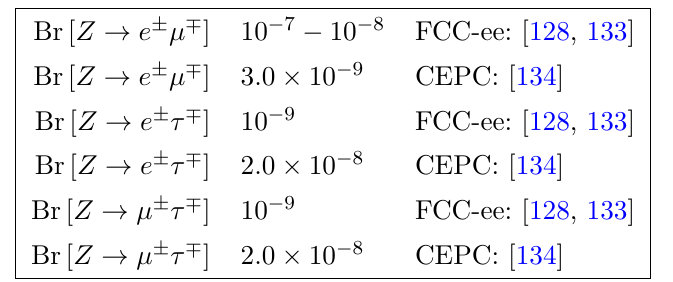
Table 5. Future sensitivities to Br( Z → ‘‘ 0 )